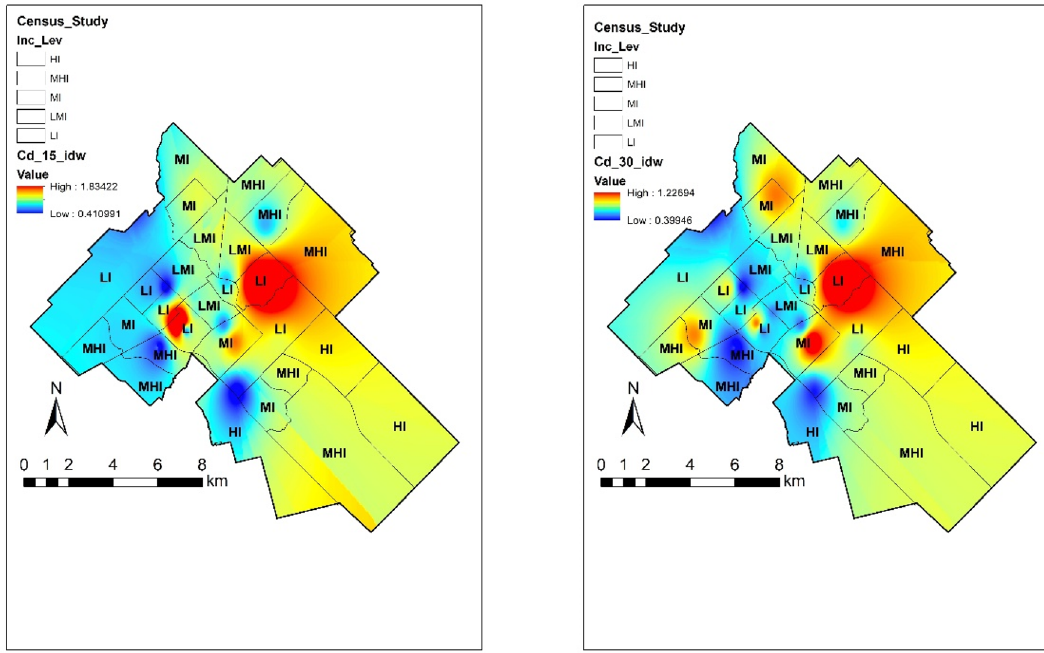
Figure 3. Cd content in 0–15 and 15–30 cm depth with varying income levels. The map was prepared by using the “Geostatistical Analyst” tool in ArcGIS 10.4 (https:// deskt op. arcgis. com/